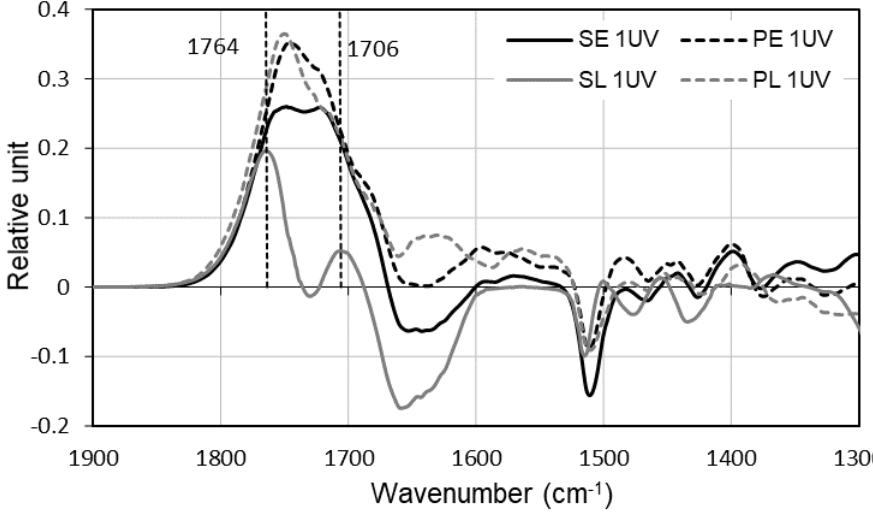
Figure 2. Difference FTIR spectra of earlywood (E) and latewood (L) for Scots pine (P) and spruce (S) species generated by one-day UV irradiation.